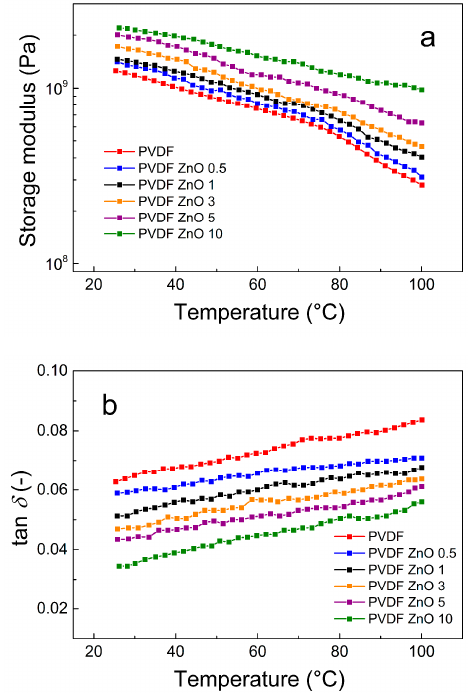
Figure 9. Temperature dependence of the storage modulus ( a ) and tan δ ( b ) for neat PVDF and the PVDF ZnO star-like composite films with various filler contents.